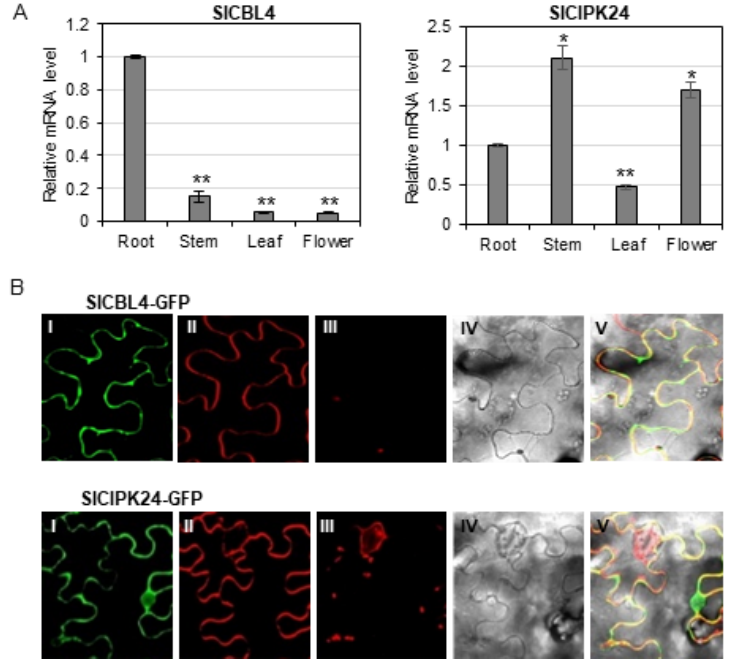
Figure 5. Expression patterns and subcellular localization of SlCBL4 and SlCIPK24. ( A ) Expression patterns of SlCBL4 and SlCIPK24 in different tomato organs using RT-qPCR analysis. The expression levels of SlCBL4 and SlCIPK24 in roots were set to 1.0 to show relative abundance differences. Tomato actin7 (NM 001308447.1) and β -tubulin (Solyc04g081490.2.1) genes were employed as internal control. Error bars denote standard deviation (SD) of three biological replicates. Significance was calculated using the Student’s t -test: * p < 0.05, ** p < 0.01. ( B ) Tobacco ( Nicotiana benthamiana ) leaf epidermal cells infiltrated with Agrobacterium (GV3101) carrying the indicated plasmids. I, II, III and IV show images of GFP, FM4-64, auto-fluorescence and bright field, respectively. V displays the merged image.